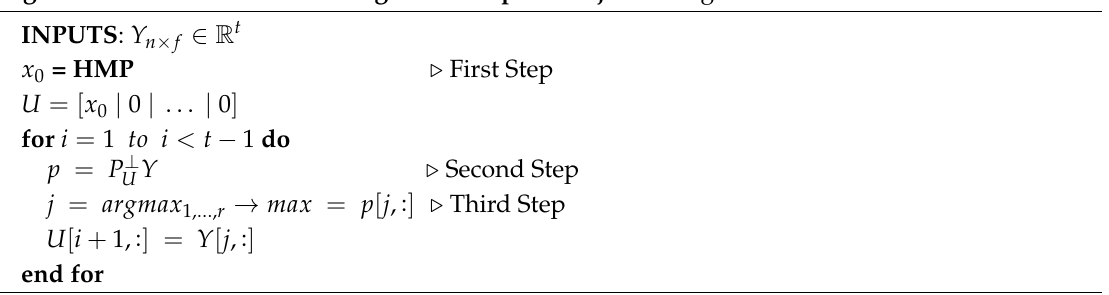
Algorithm 1 Pseudocode of Orthogonal Subspace Projection algorithm.